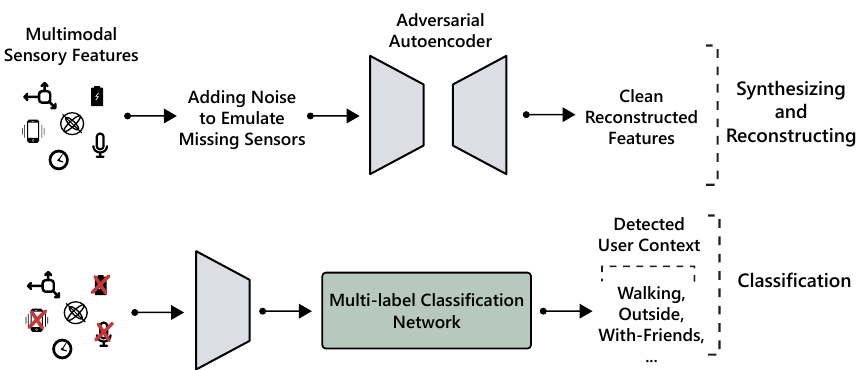
Figure 1. Overview of the proposed framework for robust context classification with missing sensory